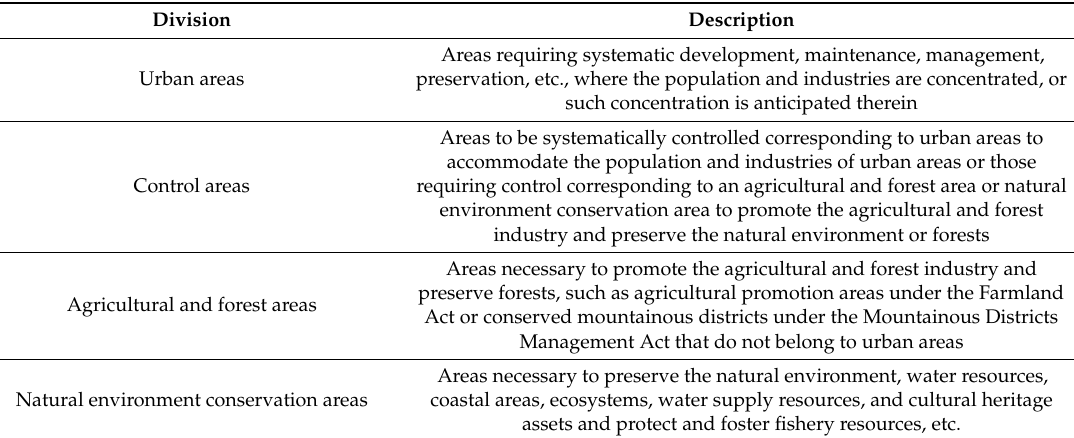
Table 2. Division of land-use zoning in South Korea defined by South Korean Ministry of Land, Infrastructure and